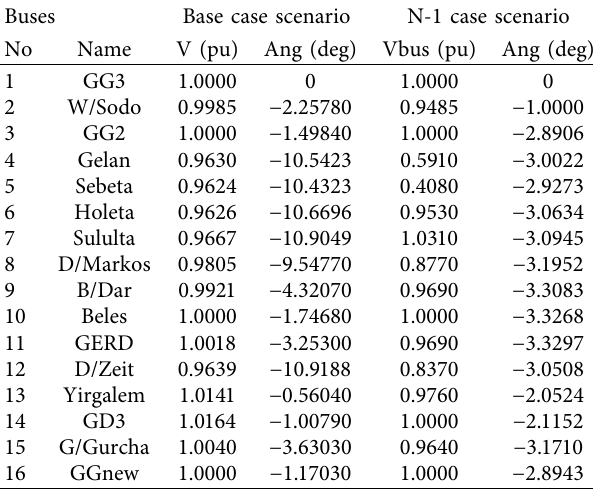
Table 5: Bus voltage magnitude and phase angle without IPFC.